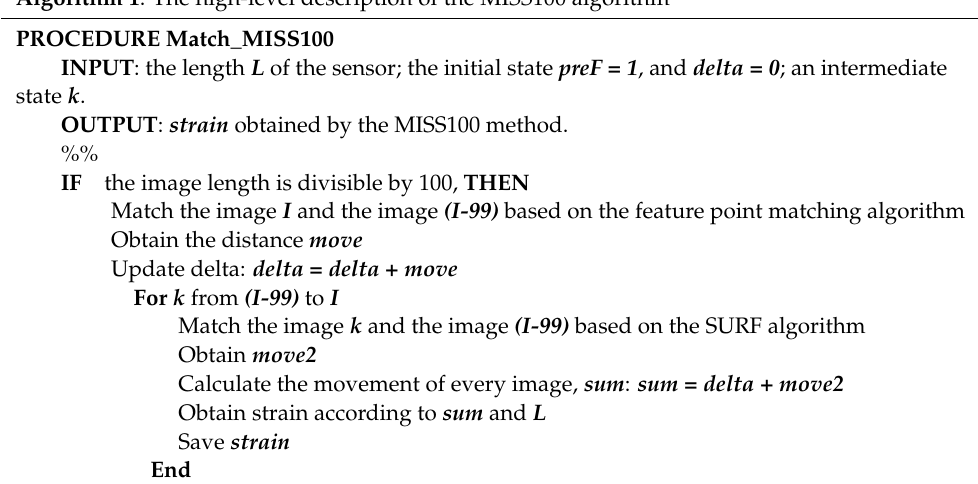
Algorithm 1 : The high-level description of the MISS100